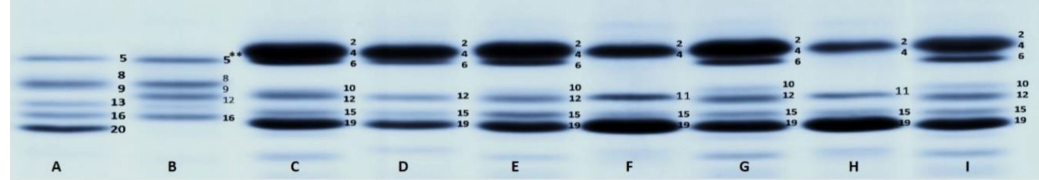
Figure 3. LMW-GS composition observed in a durum wheat set of Moroccan cultivars. Lanes are